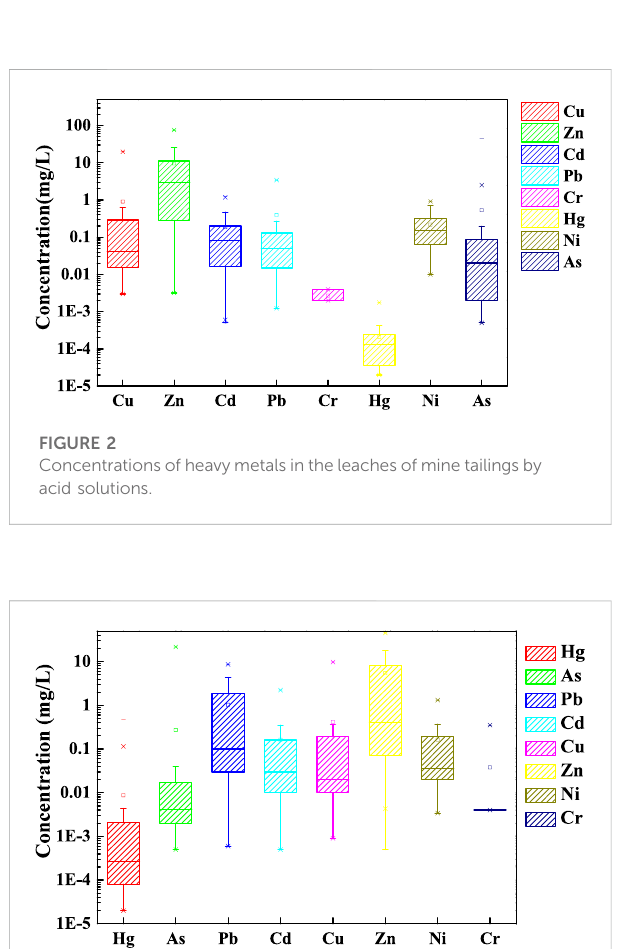
FIGURE 3 Concentrations of heavy metals in theleaches of mine tailings by pure water.